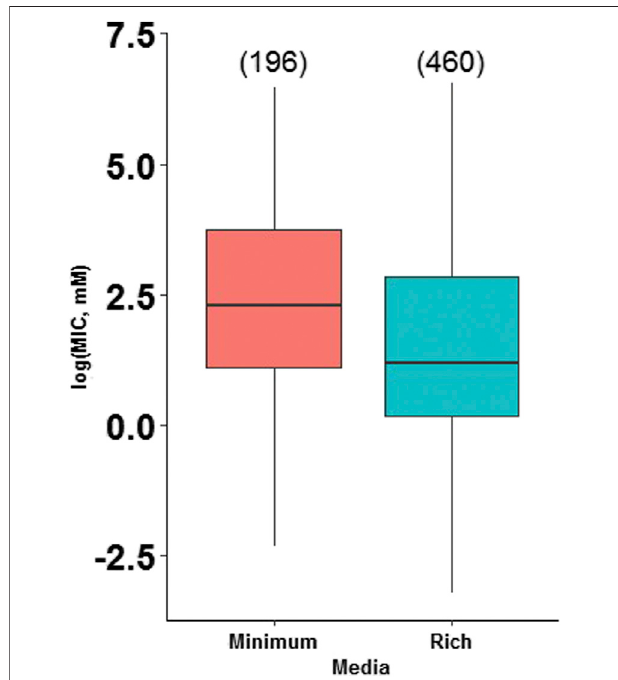
FIGURE 2 | Bacterial metal tolerance in terms of the logarithm of the Minimum Inhibitory Concentration (MIC), as a function of the type of media (Minimum and Rich) analyzed with ANOVA in RStudio 3.5.1. We present an analysis of 655 MIC values obtained from different research articles of differentstrains/speciesofbacteriaassociatedwiththeplantmicrobiome.The number of reports for each media is indicated in